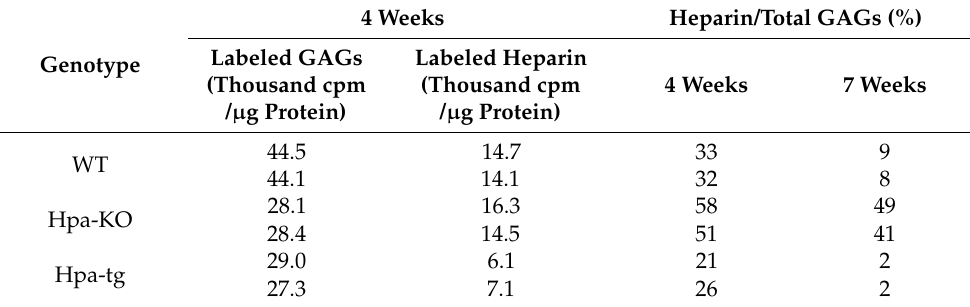
Table 1. Effects of heparanase on production of heparin and total GAGs. PCMC were cultivated for the indicated times. Metabolically 35 S-labeled GAGs were purified and expressed as total radioac- tivity (cpm) normalized for cellular protein content. Heparin content was calculated after CS/DS degradation by chondroitinase ABC (see Figure 4C). The data shown are from two independent cell cultivation for each genotype (one cultivation/mouse). Each value presented is the average of analytical duplicates. The whole experiment was repeated twice with similar